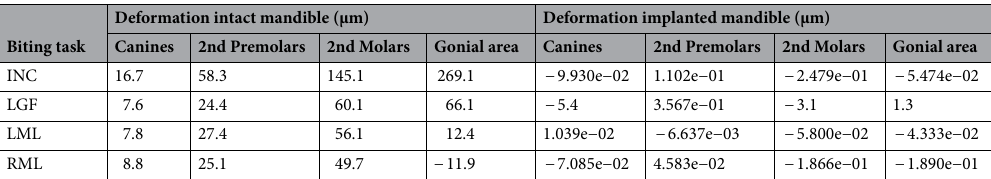
Table 3. Dental arch deformations for INC, LGF, LML and RMOL for the intact mandible under nominal bite forces (positive values of deformation imply compression).